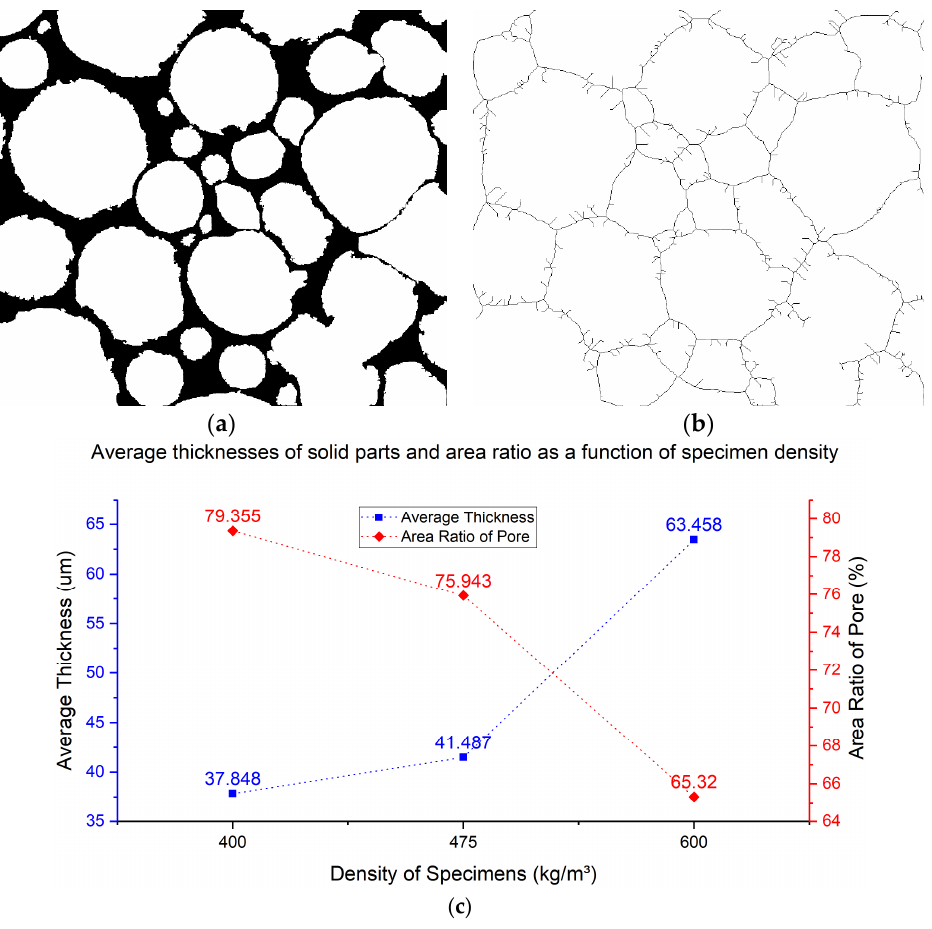
Figure 9. Average thicknesses of solid parts. ( a ) Inverted binary image. ( b ) Skeleton of the solid part. ( c ) Average thickness of solid parts and area ratio as a function of specimen density.